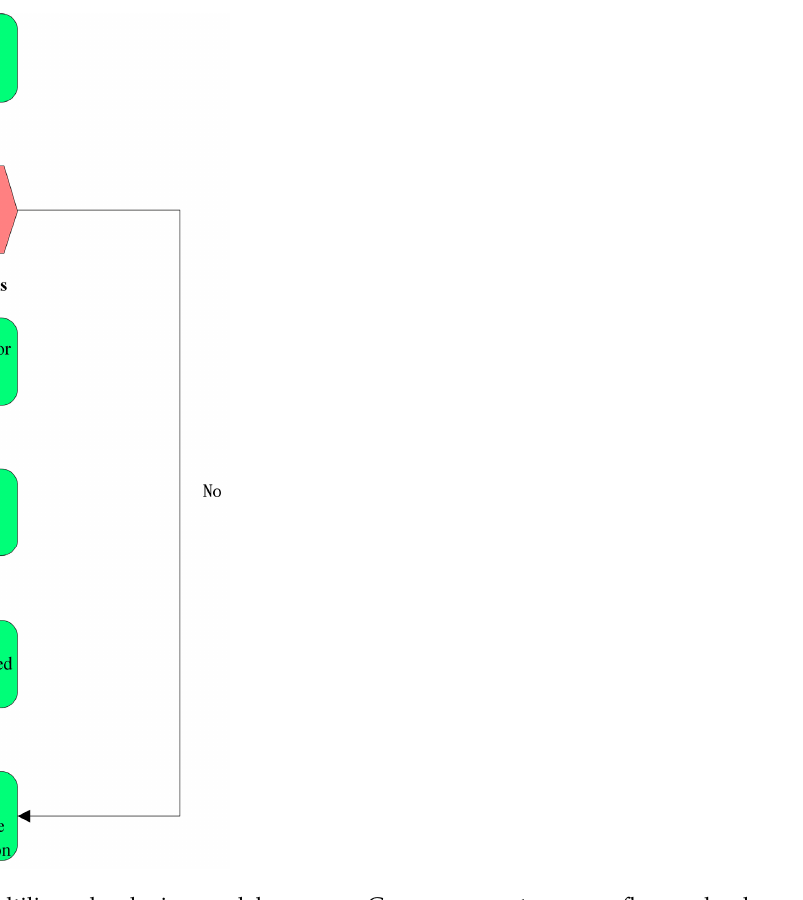
Figure 3. Multilinear hardening model program. Green represents process flow and red represents logical judgment. logical